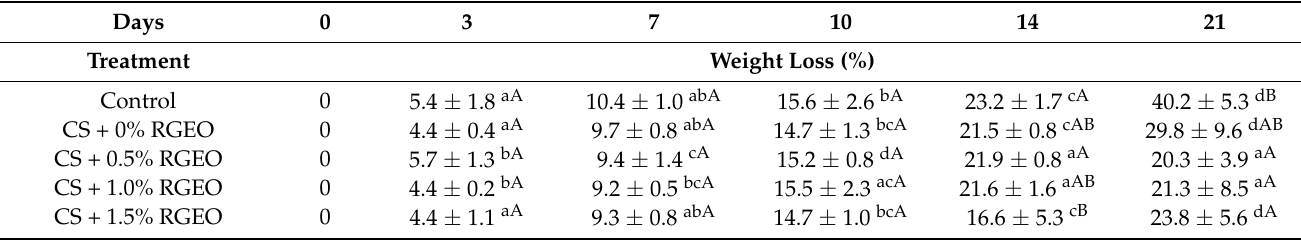
Table 1. Evolution of weight loss percentage in pears with CS + RGEO treatments: F1 = control, F2 = CS, F3 = CS + RGEO 0.5%, F4 = CS + RGEO 1.0%, and F5 = CS + RGEO 1.5%.